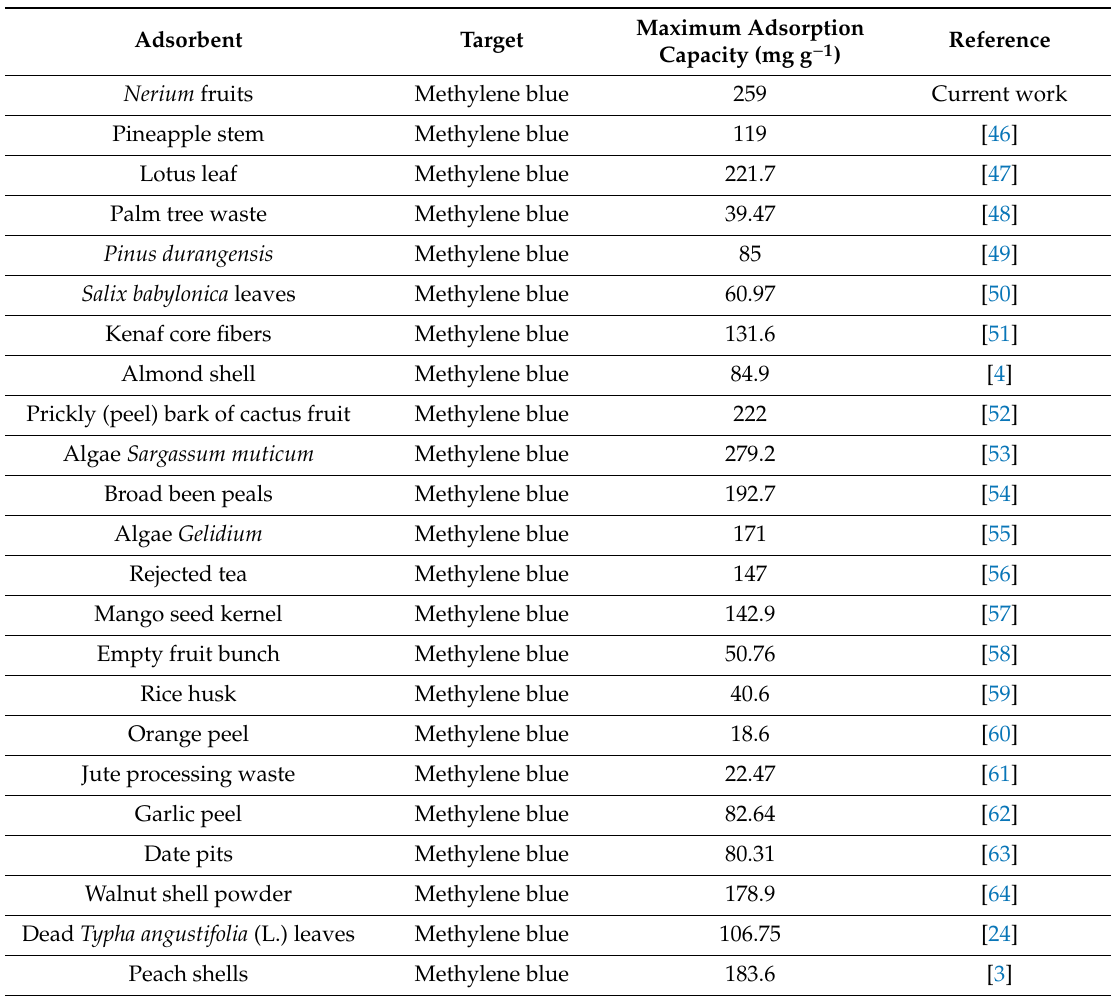
Table 1. A comparison of the biosorption capacities of methylene blue using some biomaterials published in the